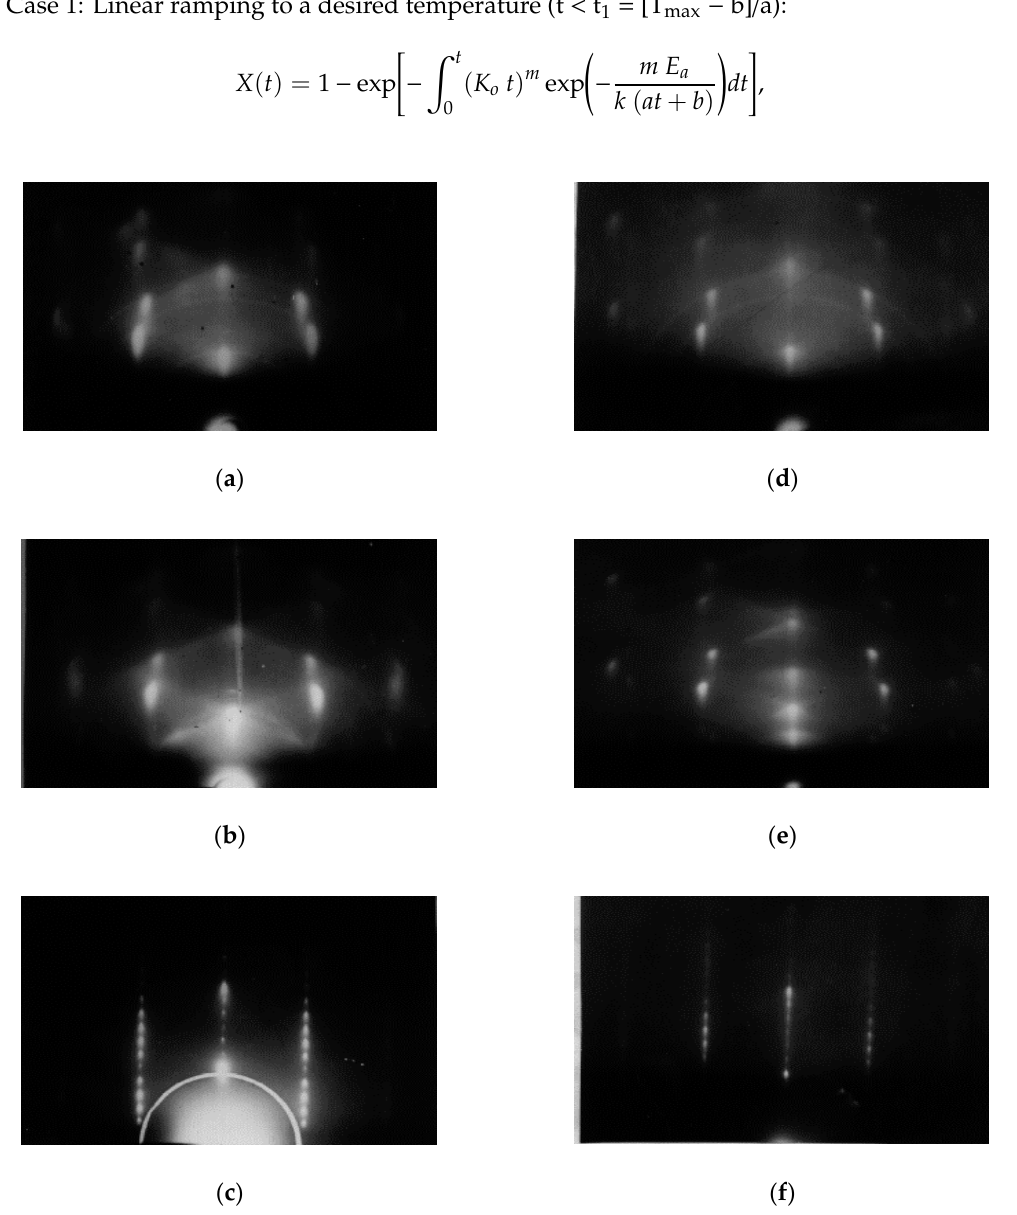
Figure 3. RHEED pattern of C-face (0001 ) -oriented 6H-SiC ion-implanted with Al + with a dose of 5 × 10 15 cm − 2 at 80 keV and RTP annealed: (a ) 30 K s − 1 to 2200 K; ( b ) 120 K s − 1 to 2200 K; ( c ) 600 K s − 1 to 2200 K; ( d ) 700 K s − 1 to 1700 K; ( e ) 700 K s − 1 to 1900 K; ( f ) 700 K s − 1 to 2200 K. Azimuth [11 2(cid:3364) 0].